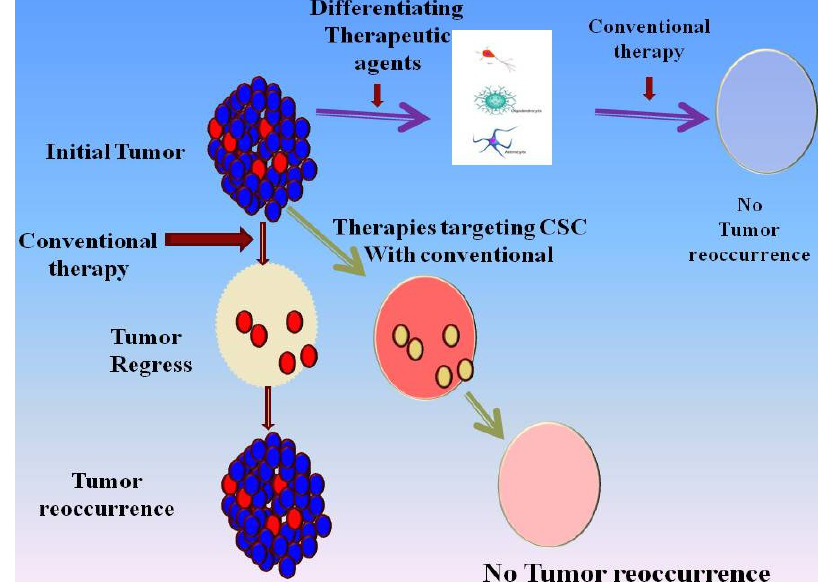
Figure 2. Figure describing the treatment options for tumors containing stem cell populations (see the text and [31,42] for